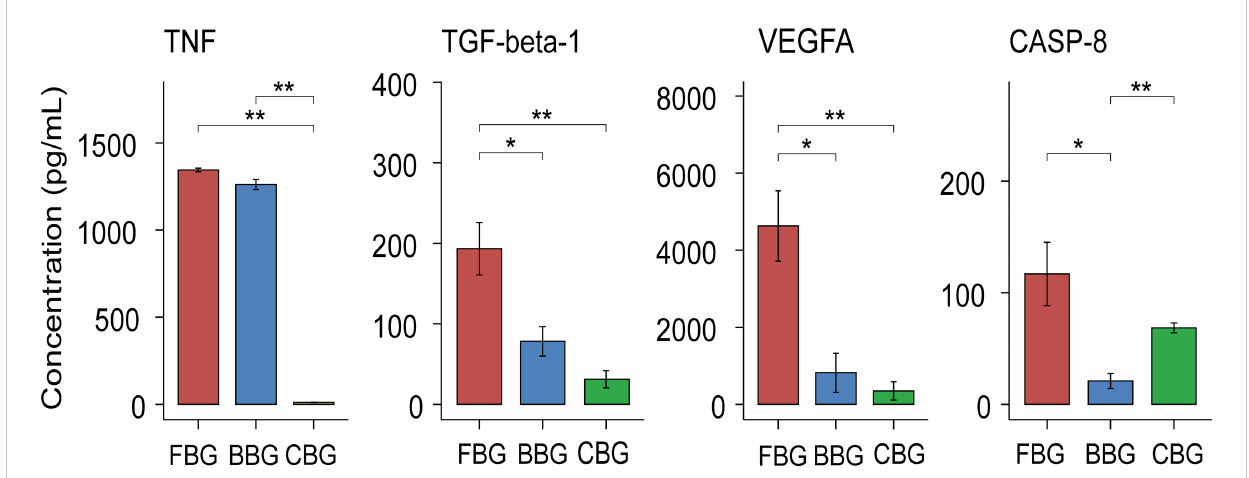
FIGURE 6 Validation of levels of in fl ammatory cytokines in blister fl uid of three groups of patients. Box plots show the Validation of levels of TNF, TGF-beta-1, VEGFA and CASP-8 in FBG, BBG and CBG. *P < 0.05, **P <